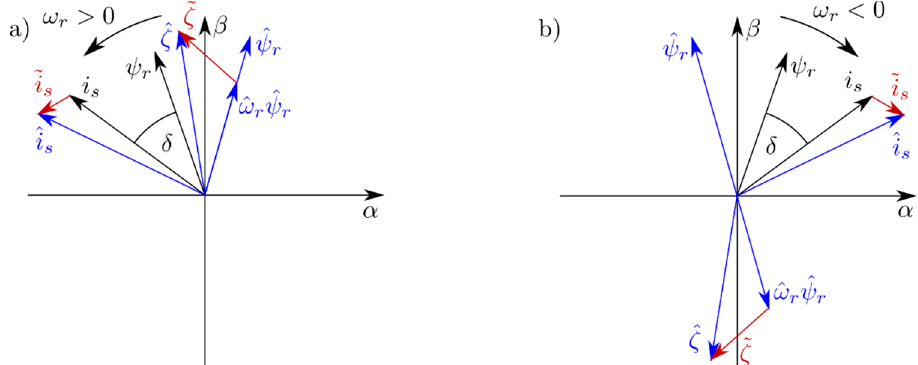
Figure 7. Real vectors of the state variables of the machine (black), estimated vectors (blue) and estimation errors (red) for: ( a ) positive speed values (vectors rotating counterclockwise) and ( b ) negative speed values (vectors rotating clockwise).